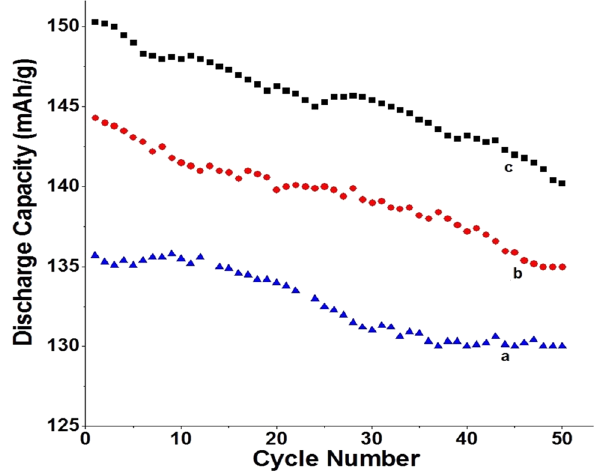
Fig. 10 Cycle performance of Swagelok cells with a PVdF, b